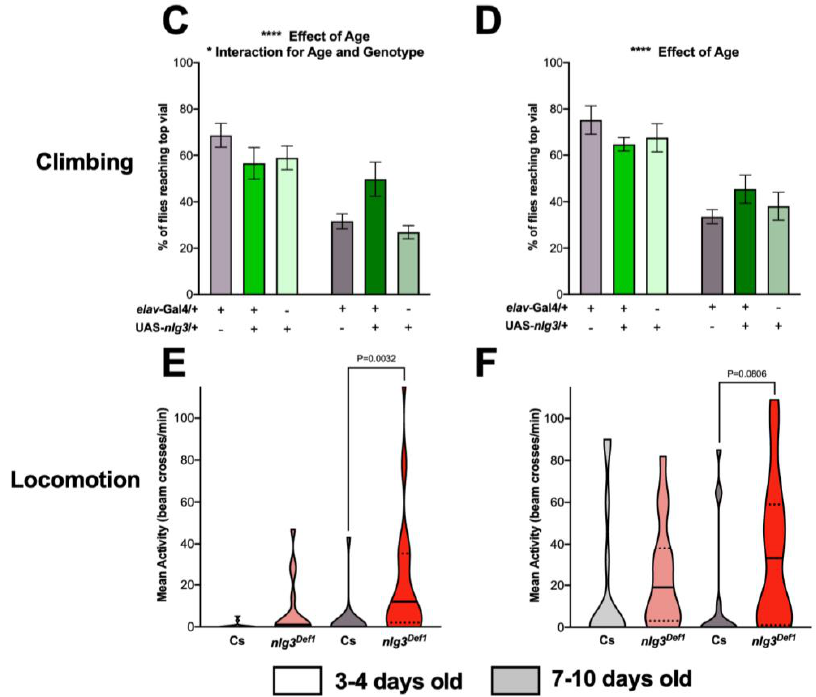
Figure 3. Locomotor activity is altered in nlg3 Def1 flies. ( A , B ) Startle-induced climbing represented by the mean percent ± s.e.m. of flies reaching the top vial. ( A ) nlg3 Def1 males had less flies than Cs reaching the top vial at 3–4 days old (two-way ANOVA –effect of genotype: F 1,31 = 4.464 , p = 0.0428). However, this was not the case at 7–10 days old, where there was no difference between Cs and nlg3 Def1 . Cs males also had less flies reaching the top vial at 7–10 days old compared to 3–4 days old but this difference was not observed in nlg3 Def1 (two-way ANOVA—effect of age F 1,31 = 9.391 , p = 0.0045; interaction between age and genotype F 1,31 = 4.780 , p = 0.0365). ( B ) nlg3 Def1 females had less flies than Cs